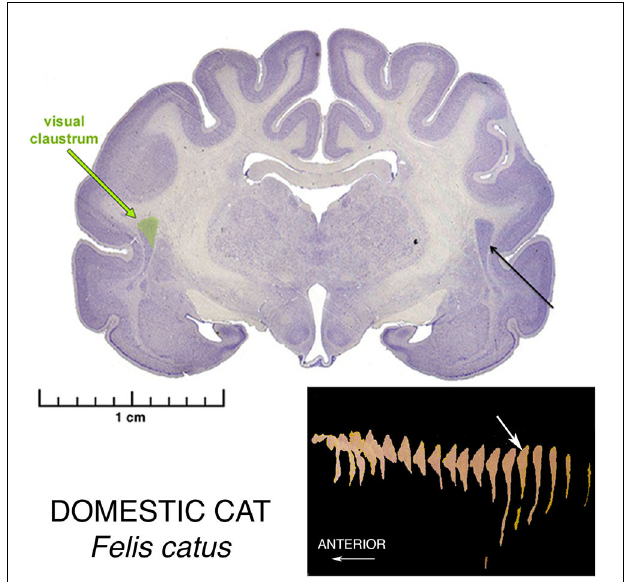
FIGURE 2 | Nissl stained coronal section the brain of a Domestic Cat, illustrating the morphology of the Superior Pyramidal Puddle. Within the puddle, the green color shows the location of the Visual Sensory Area of the claustrum. The Somatosensory Area is located just rostral, and the Auditory Area just rostro-inferior to the Visual Area. The Visual Area is the largest of the three. The white arrow in the three-dimensional reconstructions shows the location of this section in the whole claustrum. These sensory areas are found in only the posteriormost part of this